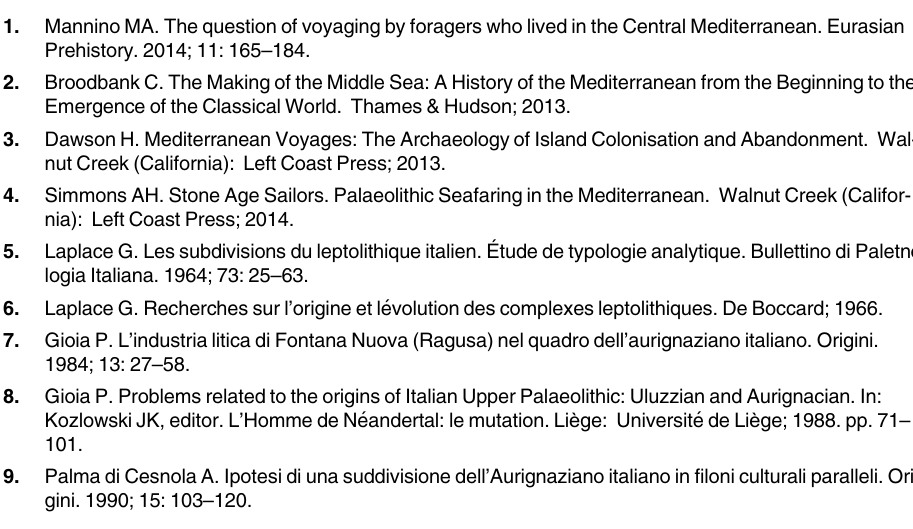
S25 Fig. Homo sapiens , parietal fragment (Fon-23), before the sampling. (JPG) S26 Fig. Homo sapiens , molar II (Fon-24), before the sampling. (JPG) S27 Fig. Homo sapiens , premolar III (Fon-25), before the sampling.